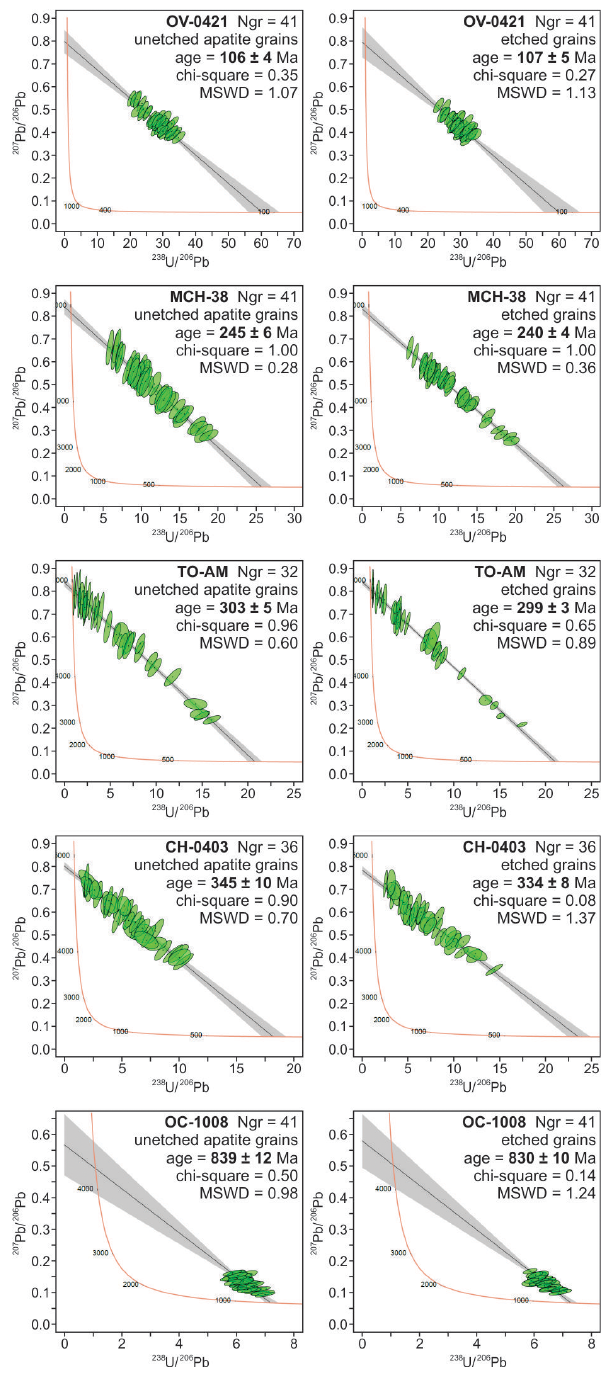
Figure 2. Tera–Wasserburg Concordia diagrams for the U–Pb results of unetched and etched apatites from samples OV-0421, MCH-38, TO-AM, CH-0403, and OC-1008. MSWD – mean square weighted deviation, Ngr – number of grains dated. Errors are given in 2 σ